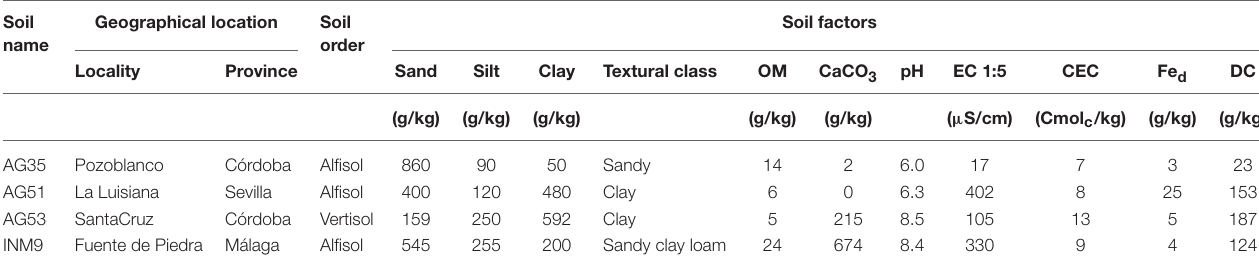
TABLE 1 | Geographical location and physicochemical properties of the soil samples used in this